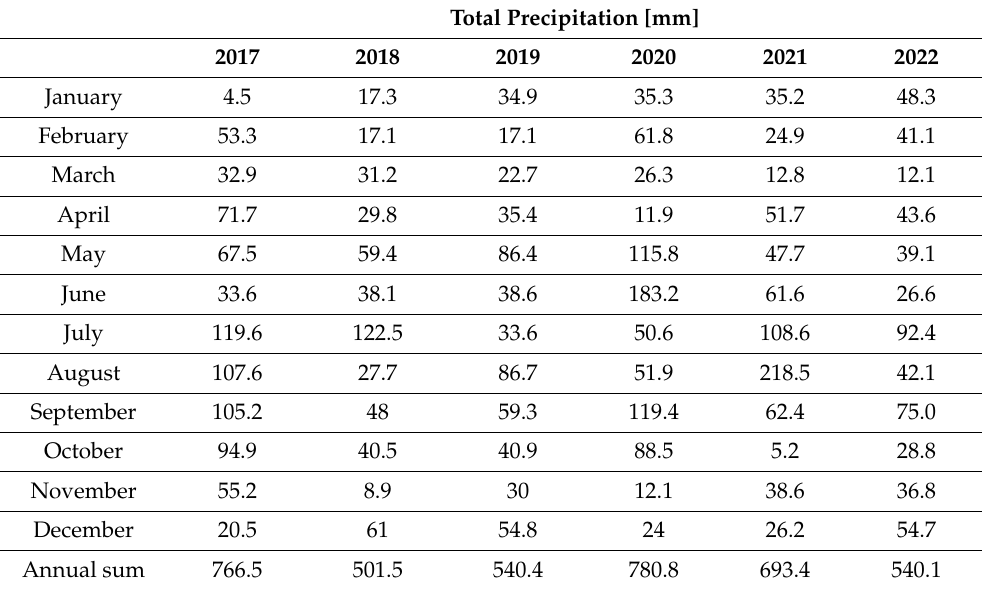
Table 3. Monthly and annual precipitation sums in Osiny for the period of